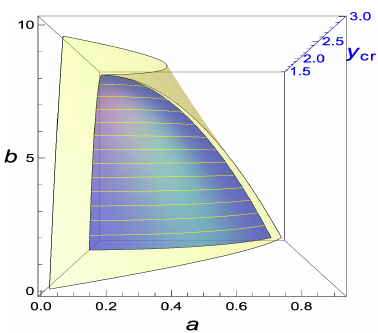
Figure 11. The critical surfaces for the horizon (inner surface) and the light-ring (outer surface). The critical surface of the light-ring follows the one of the horizon, only further out. Note the region where the light-ring does not exist. The b value is equal to b n . For the construction of the light ring surface, (38) was used. The corresponding MATHEMATICA routine can can be retrieved from